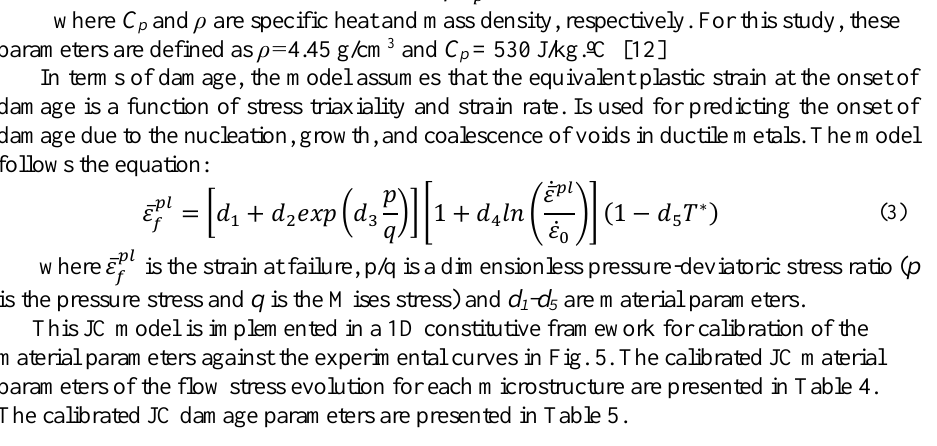
Table 4: JC material model parameters calibrated against experimental results